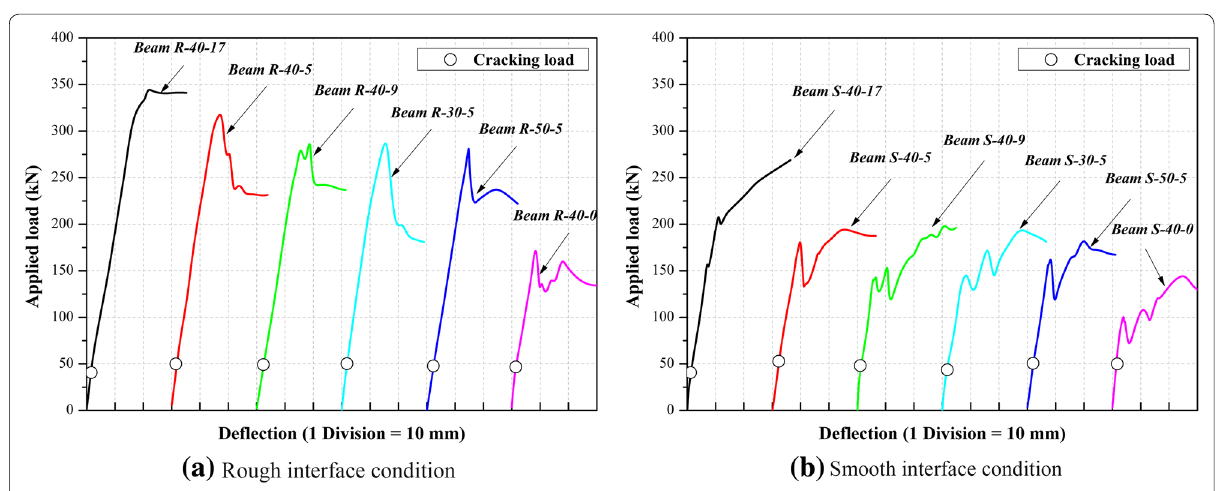
Fig. 8 Load-deflection curves at mid-span for all